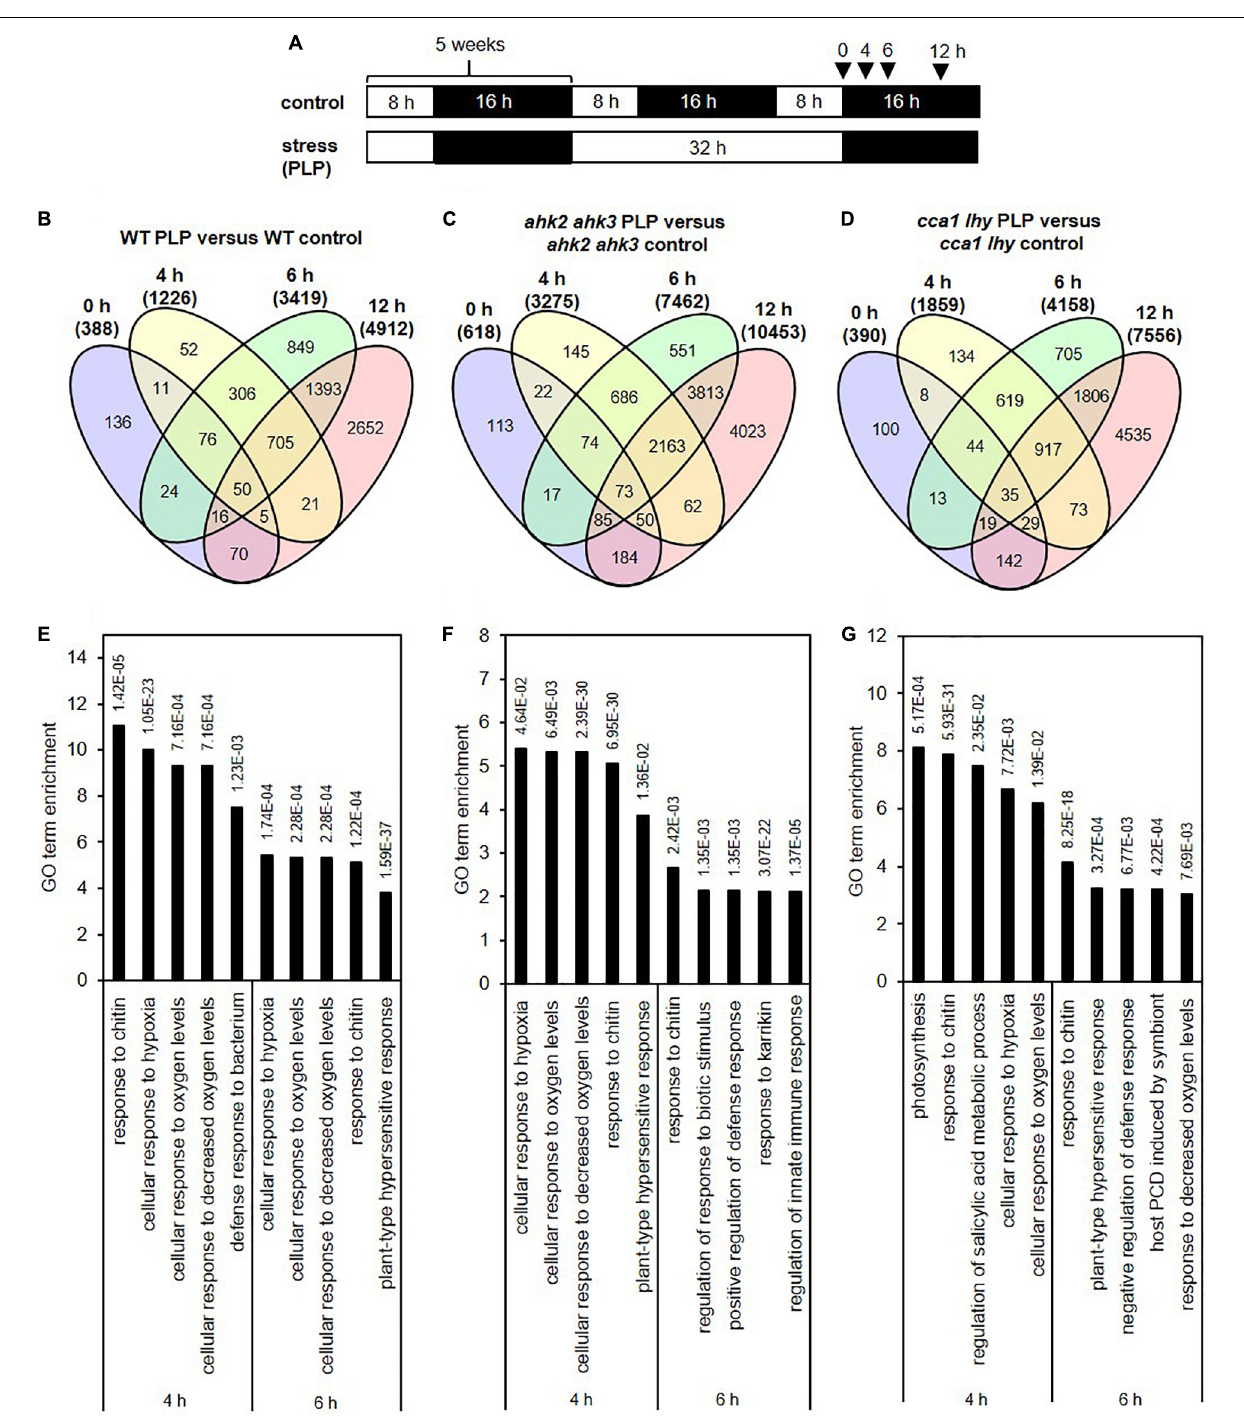
Frontiers in Plant Science |